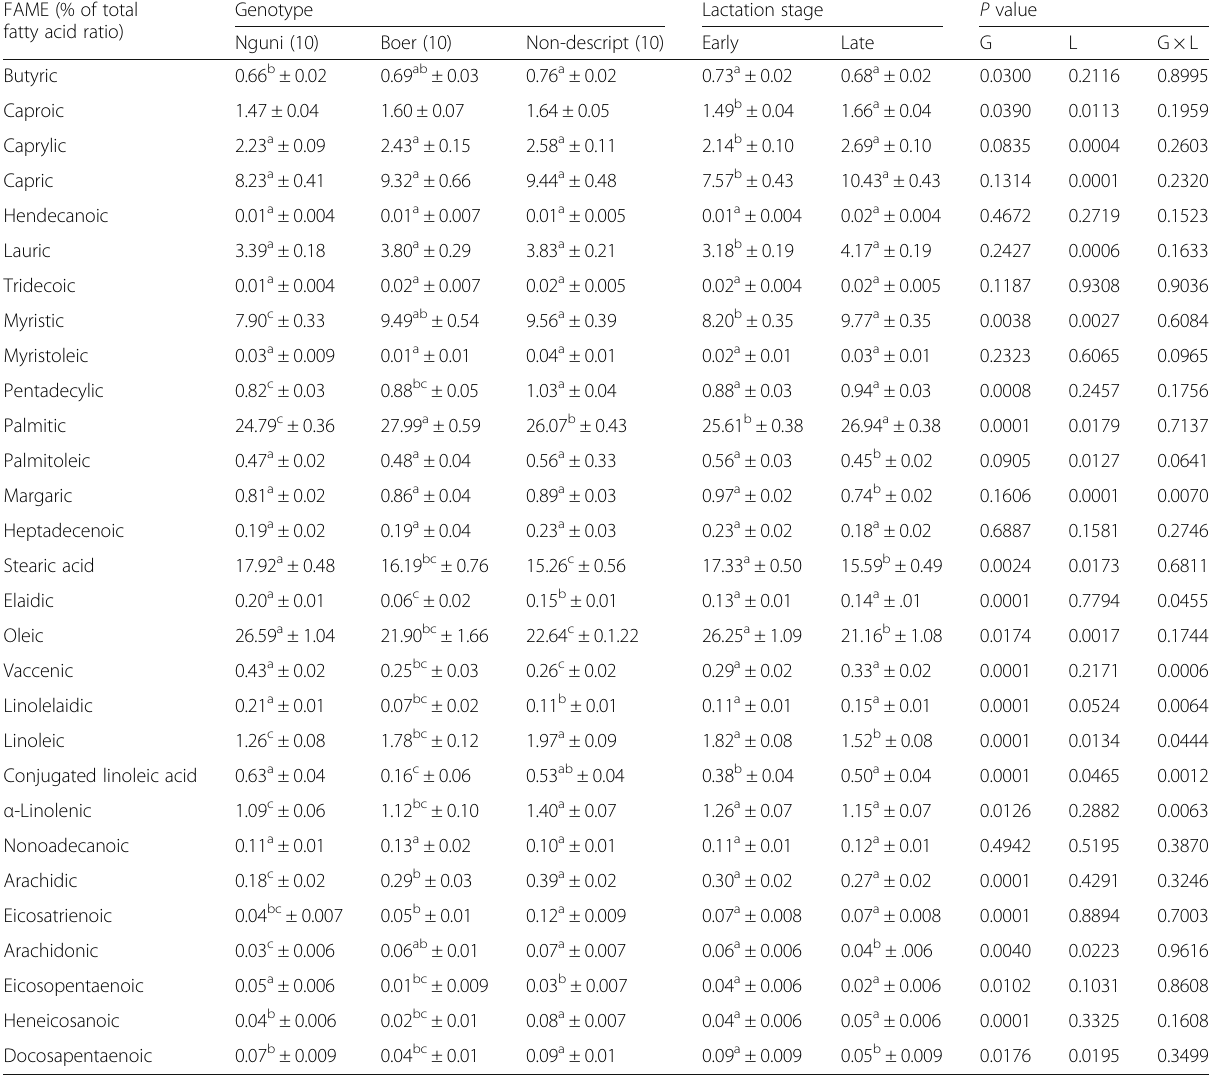
Table 2 Effect of genotype, lactation stage and interaction between genotype and lactation stage on fatty acid relative to total % fatty acid content of free-ranging indigenous